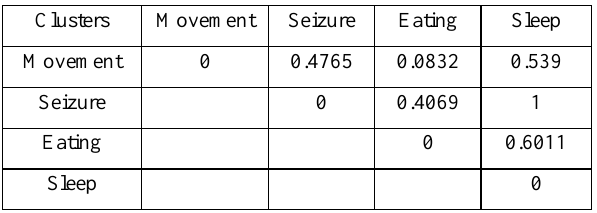
Table 1 . Relative distances between cluster centers.